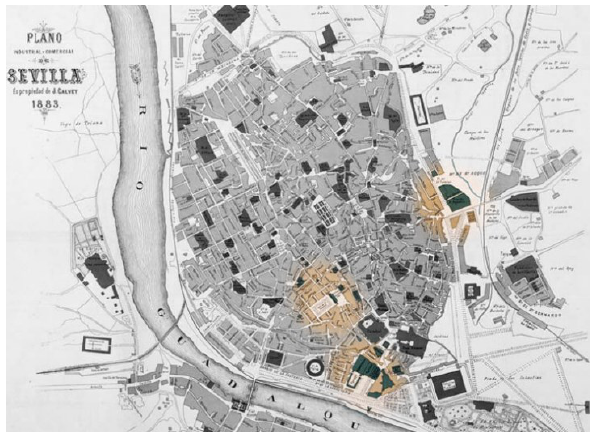
Figure 1. Map of the city of Seville in 1883, property of J. Calvet. The three cases of studies are indicated: the convent of San Agustin in the upper right part, the Plaza Nueva in the center and the Royal Shipyards in the lower part. (Consulted in the Virtual Exhibition of the National Library of Spain,